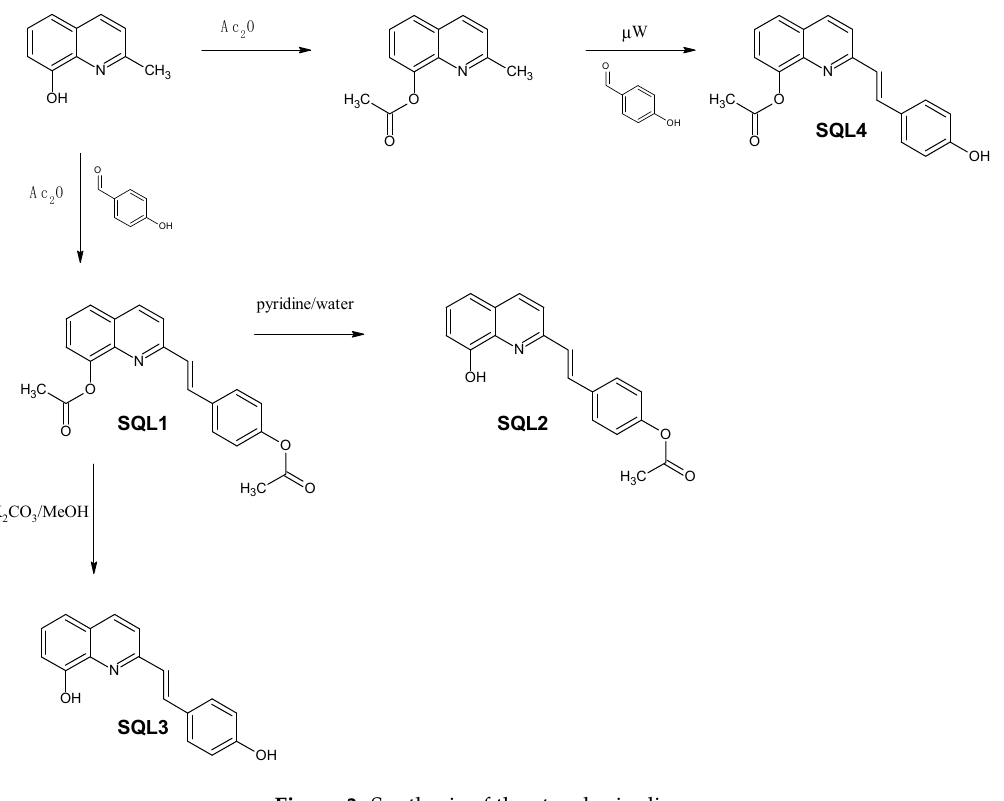
Figure 3. Synthesis of the styrylquinolines.